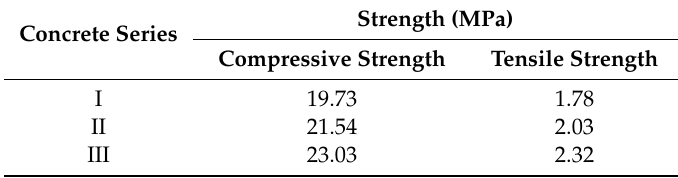
Table 3. The compressive strength and the tensile strength of tested concrete under quasi-static loading.